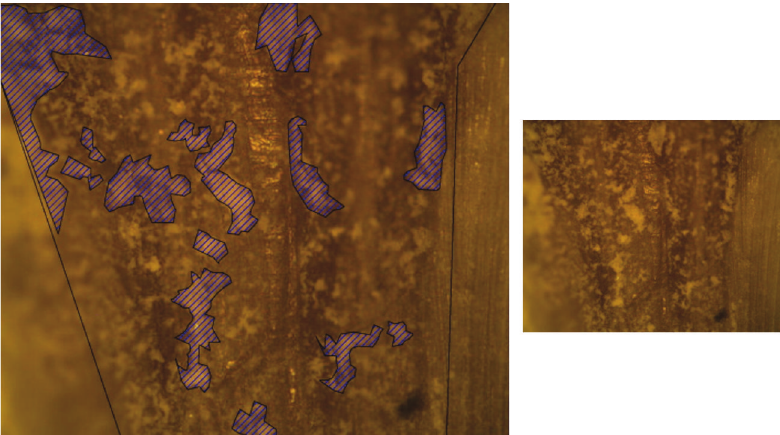
Figure 2: Root filling material remaining in the middle third of a specimen obturated with gutta-percha/ZOE sealer and retreated using